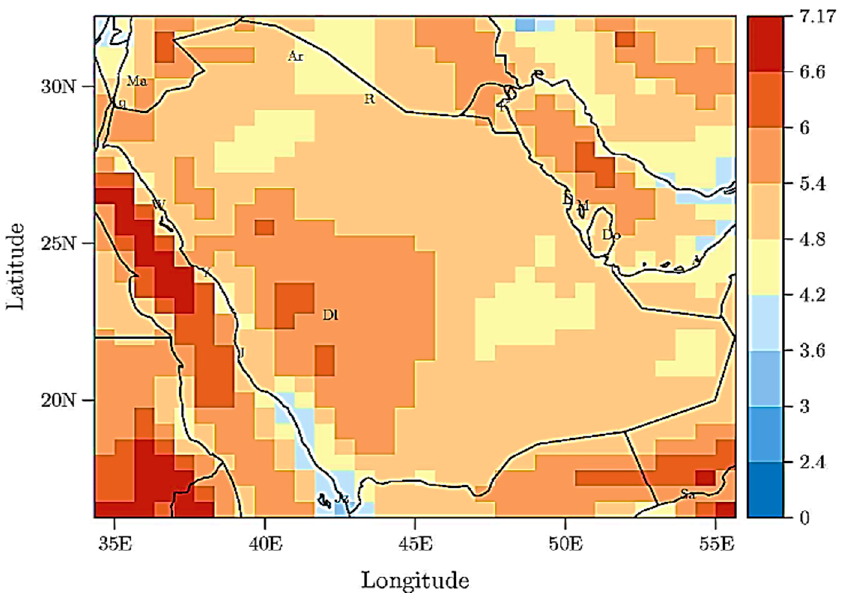
Figure 7. Average wind speed (m s ⁻ 1 ) of the GCC region is computed at 100 m. Copyright © 2021 Elsevier [87].